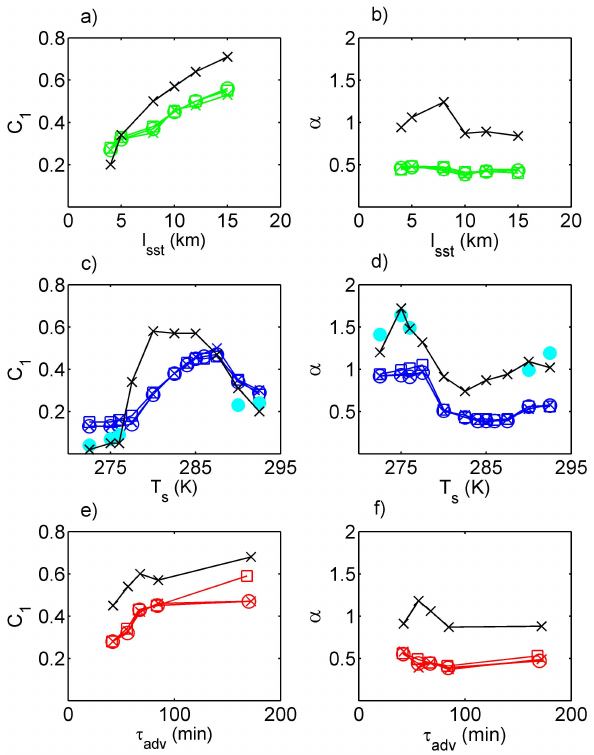
Fig. 10. C 1 and α computed from 3-D averages of q c horizontal fluctuations against: (a, b) l sst , (c, d) T s and (e, f) τ adv . Black lines represent values computed from P 5h ac . Green, blue and red lines are computed from q c . The light blue markers lines are computed from q i . “x”, “o” and “ (cid:3) ” markers represent simulation times 05:00h, 04:00h and 03:00h,